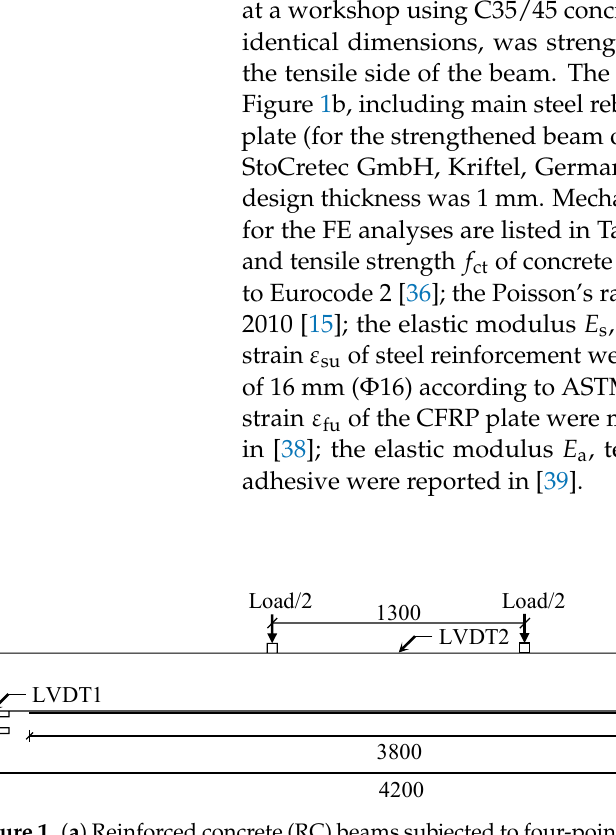
Figure 1. ( a ) Reinforced concrete (RC) beams subjected to four-point bending tests until failure (unit: mm); ( b ) cross-sectional dimension of the RC beams (with a carbon-reinforced polymer (CFRP) plate for the strengthened beam only). Table 1. Material properties of concrete, steel rebars, CFRP plate, and cured epoxy